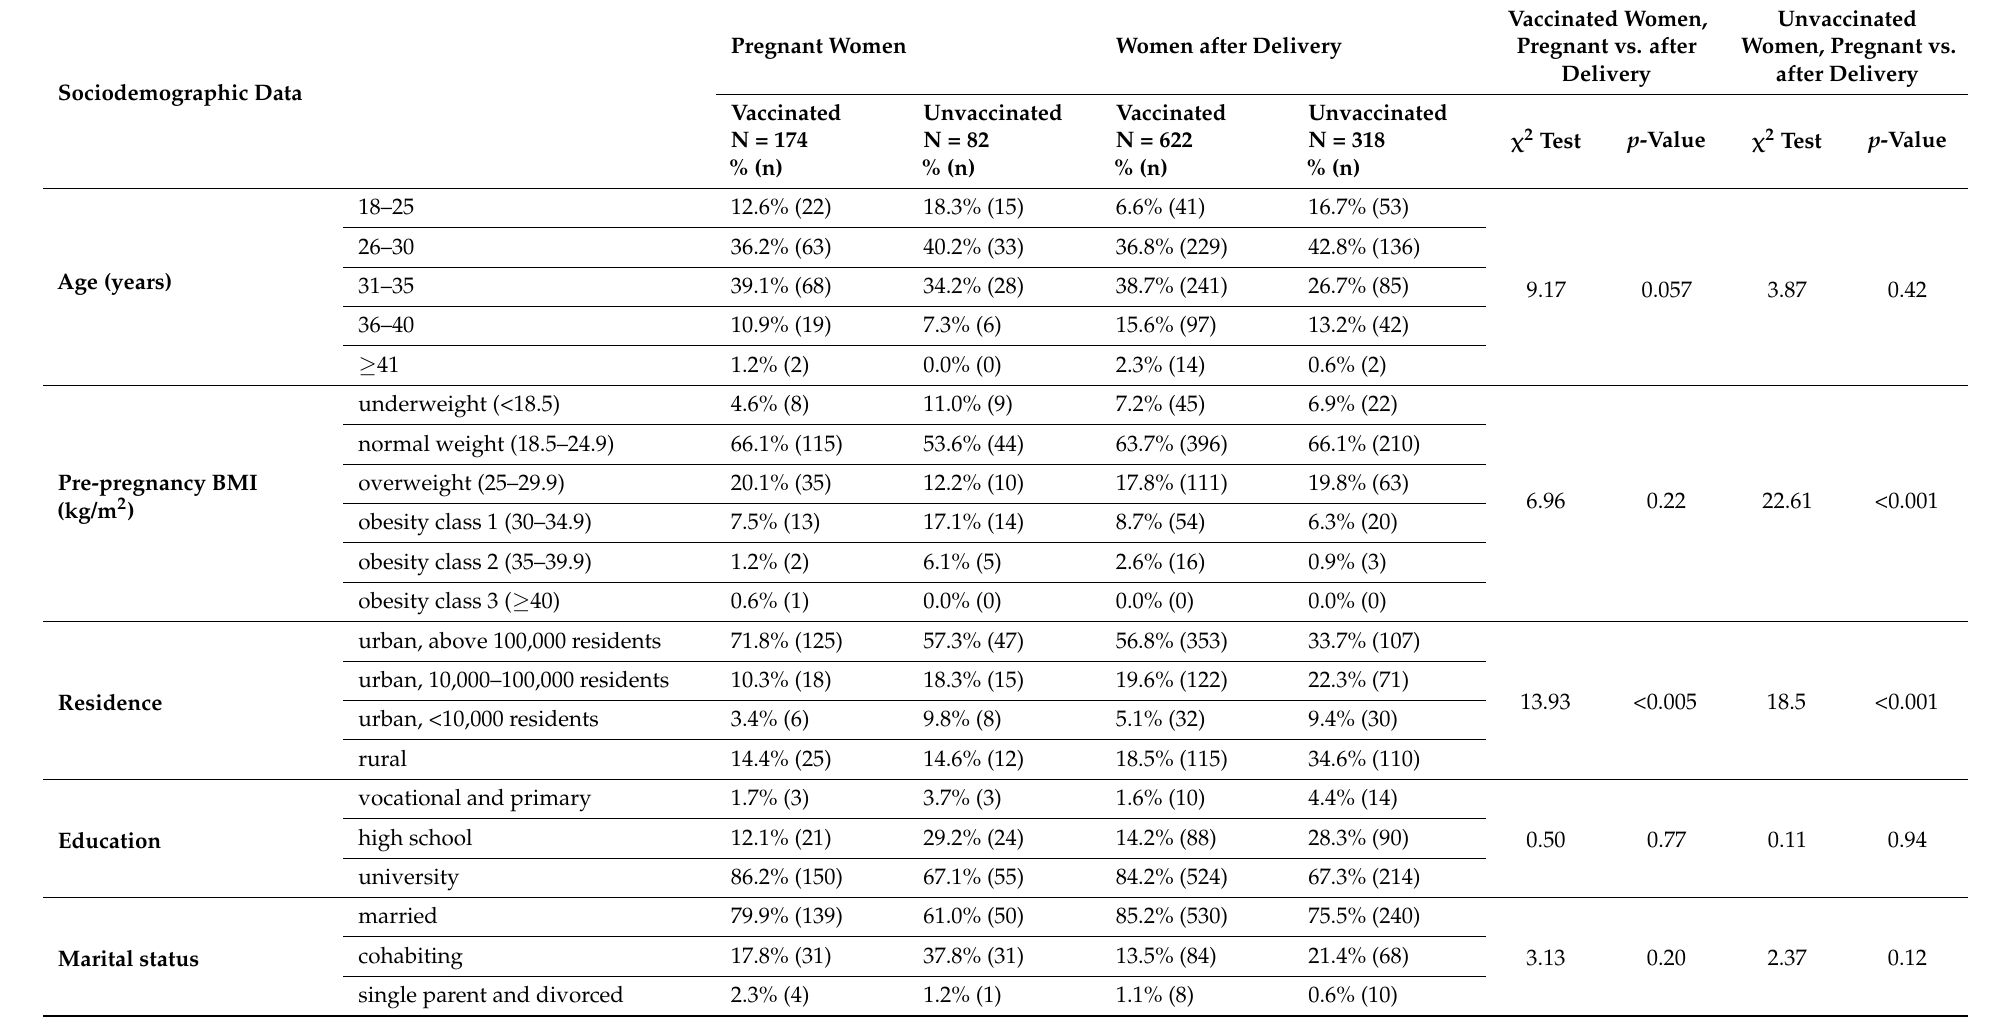
Table 3. Level of COVID-19 vaccination among pregnant and breastfeeding women in relation to sociodemographic and obstetric characteristics.